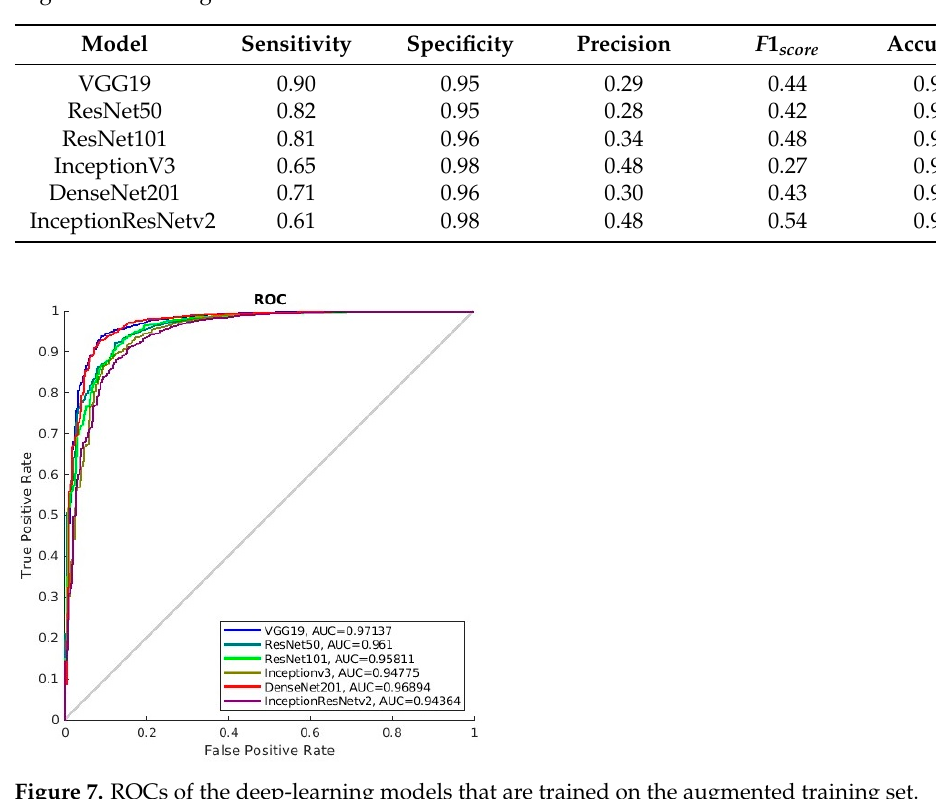
Figure 7. ROCs of the deep-learning models that are trained on the augmented training set .